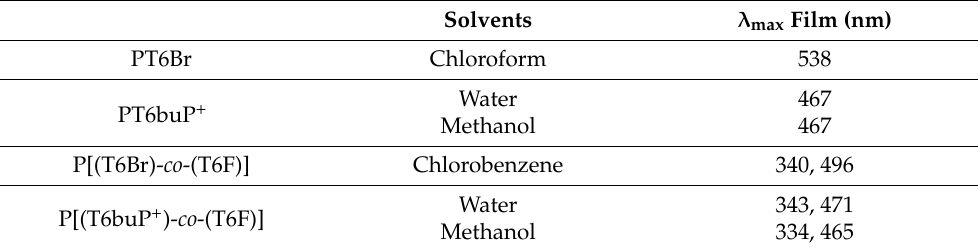
Figure 4. UV – Vis spectra of homo- ( A ) and double-cable copolymers ( B ) in thin film by drop-casting from different sol- vents.